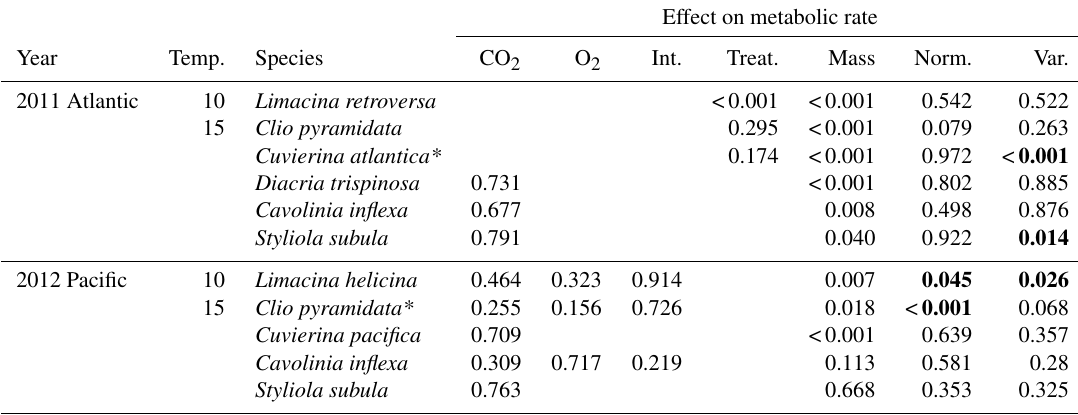
Table 5. Statistical results of the univariate general linear models (GLM) for each species were analyzed separately by year and are listed relative to the temperature of the experiment (Temp.; ◦ C). For species studied at multiple temperatures (denoted by ∗ ), the metabolic rates were adjusted to 15 ◦ C using a Q 10 = 2 to allow for direct comparison. The effect of the independent factors of CO 2 level (CO 2 ) , O 2 level (O 2 ) , their interactive effect (Int.), and the covariate of mass were analyzed in regards to the metabolic rate and reported as p values for the Pacific (mean mass-specific metabolic rate values found in Table 4). For the Atlantic, each treatment was tested as independent (Treat.) due to the accidentally low CO 2 condition in the LC/LO gas mixture. We report whether the data met the assumption of normality of the residuals with Shapiro–Wilk (norm.; for p under 0.05 the assumption is not met) and heterogeneity of variance (var.; for p under 0.05 the assumption is not met) and denote in bold where the dataset did not fully meet these statistical assumptions. Note that for the sole case where the treatment or CO 2 effect was significant ( L. retroversa ) all assumptions were met. Effect on metabolic rate Year Temp. Species CO 2 O 2 Int. Treat. Mass Norm.